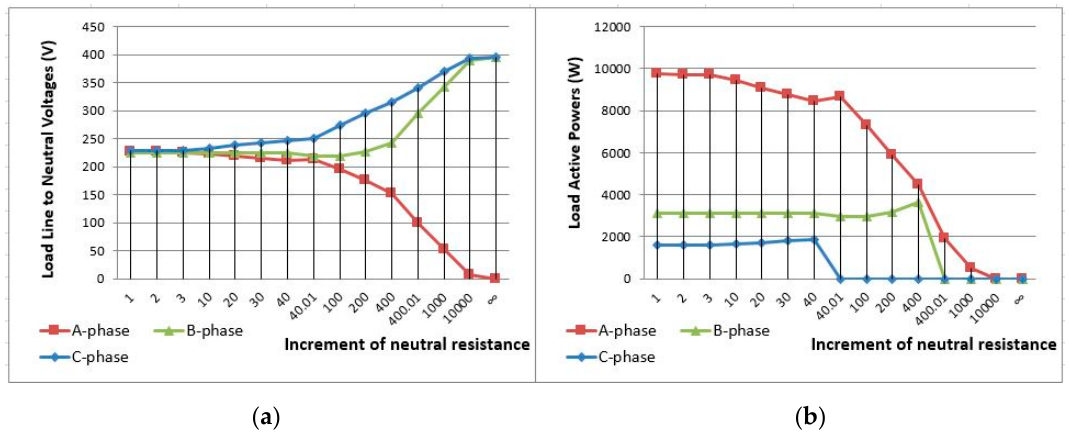
Figure 3. Voltages and powers in the load phases: ( a ) active power; ( b ) line-to-neutral voltages.